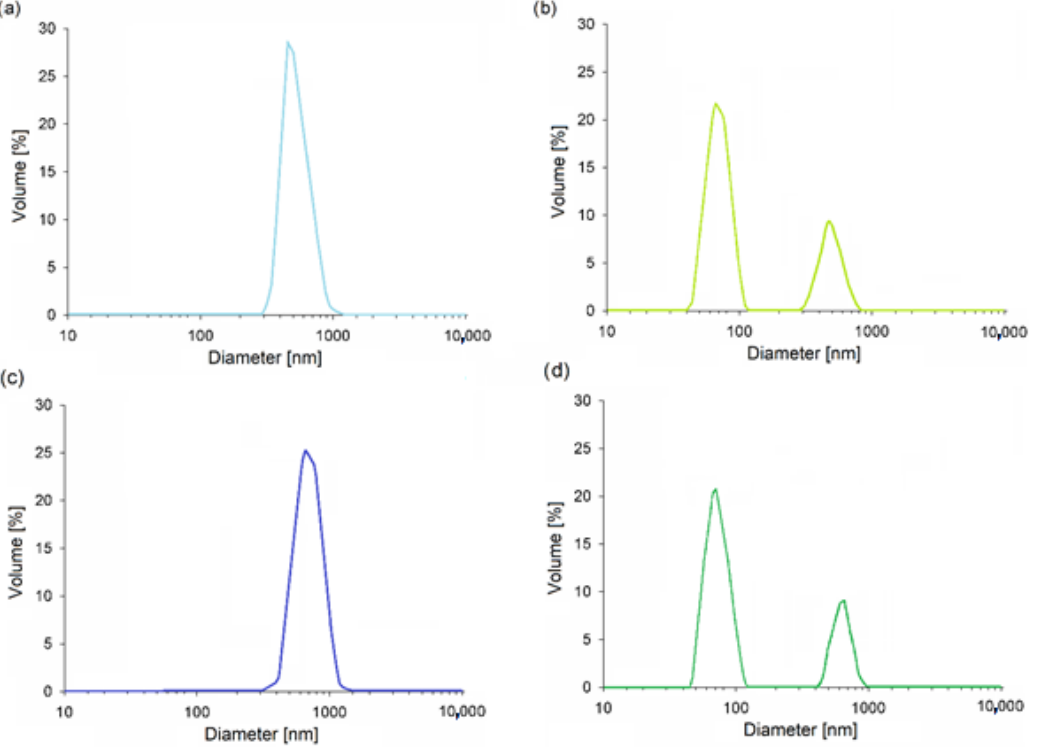
Figure 3. Particle size distribution for: ( a ) C I; ( b ) NC II; ( c ) mC I; and ( d ) mNC II.